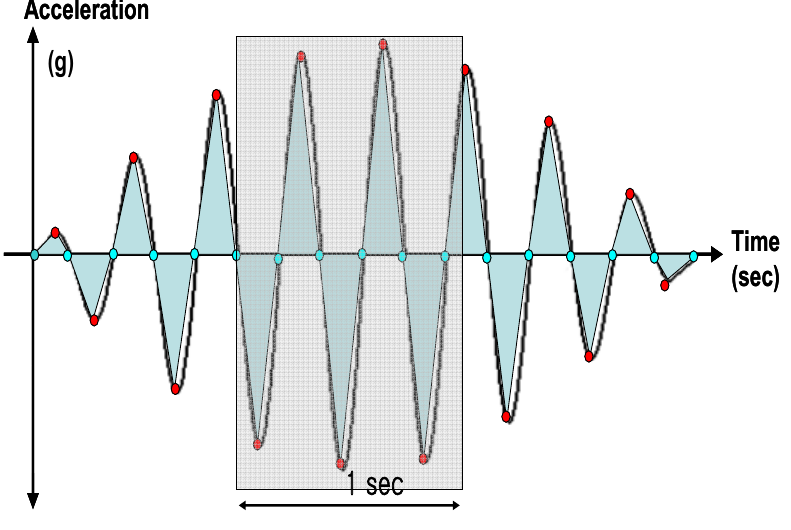
Figure 4. Acceleration waveform and the method of defining the movement index (the sum of areas per second) [2].